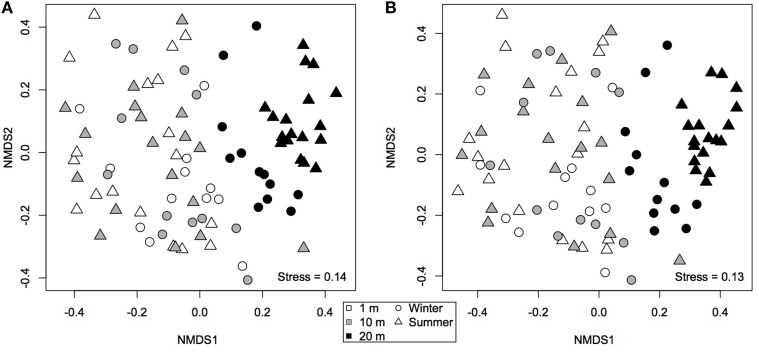
Non-metric multidimensional scaling ordination based on (A) Bray-Curtis and (B) modified Raup-Crick (Chase et al., 2011) dissimilarities. Communities that are closer together, using modified Raup-Crick dissimilarities, are more deviant from the null expectation, whereas communities that are farther apart are less deviant from the null expectation.